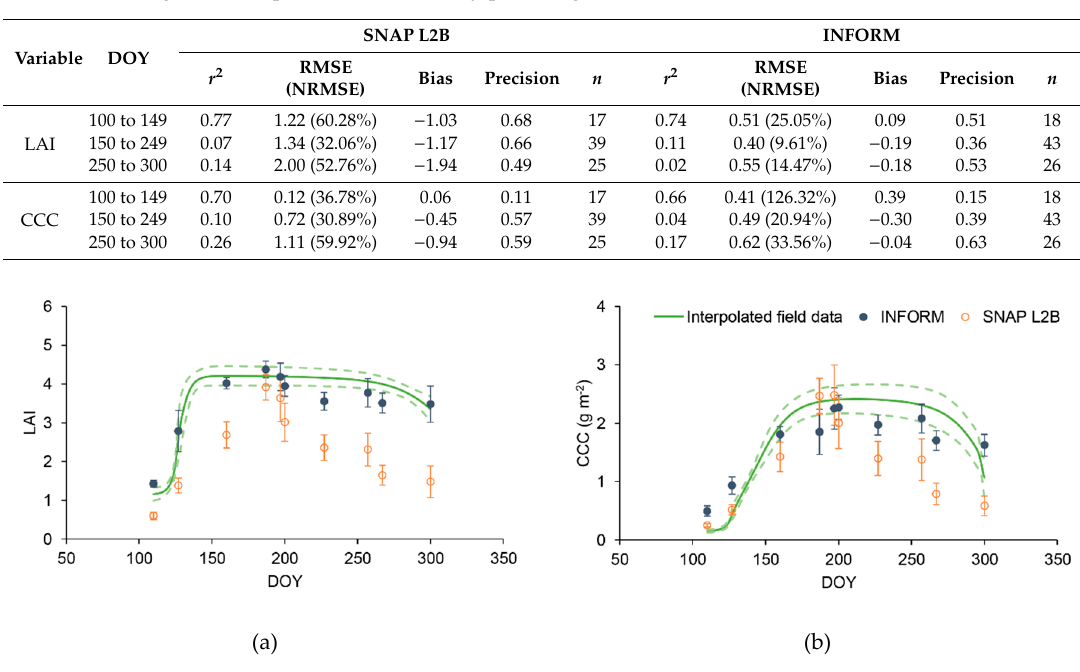
Table 5. Performance statistics for the SNAP L2B and INFORM-based retrieval algorithms when evaluated against interpolated field data, by phenological subset.